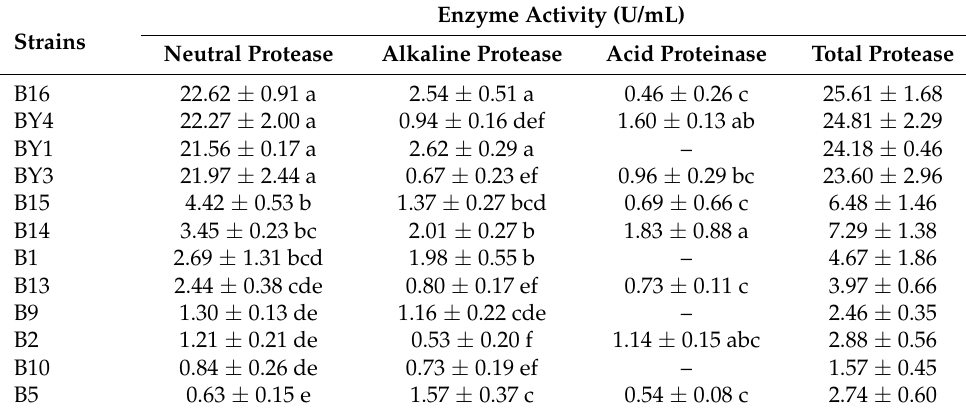
Table 3. Re-screening of proteases-producing